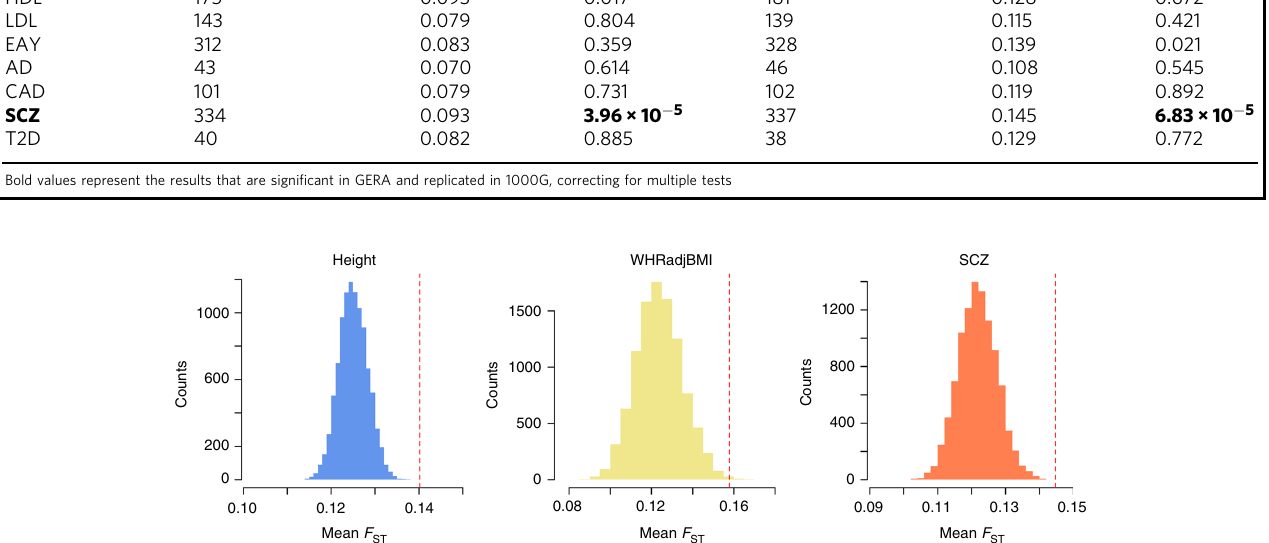
Fig. 1 Mean F ST values of the associated SNPs across 1000G populations against the null distribution for height, WHRadjBMI and SCZ. The red dashed line represents the mean F ST of the trait-associated SNPs clumped at P < 5 ´ 10 (cid:2) 6 . The histogram represents the distribution of mean F ST values of the sets of control SNPs. WHRadjBMI waist-to-hip ratio adjusted by BMI, SCZ schizophrenia